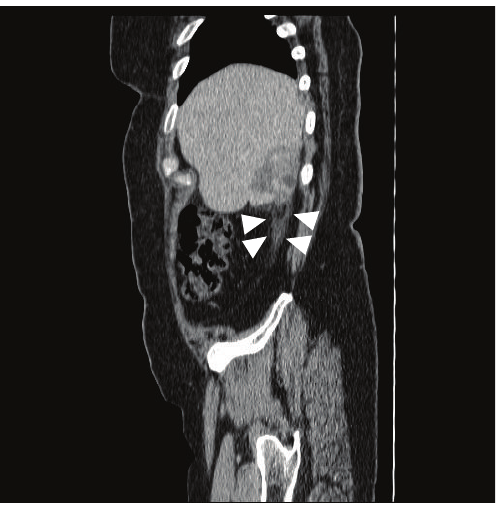
Figure 4: Reimaging of the abdomen with computed tomography three days subsequent to the original study in the coronal plane exhibits an increase in the amount of paracolic gutter fluid (arrowheads), and the craniocaudal dimension of the hemangioma is now 73.8